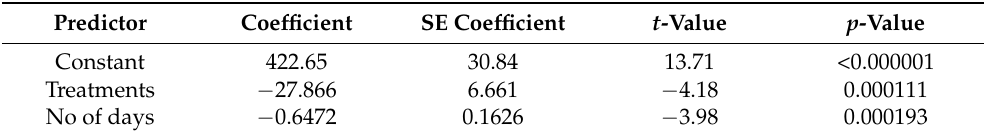
Table 4. The statistical analysis between treatments and number of days using Minitab software- based.